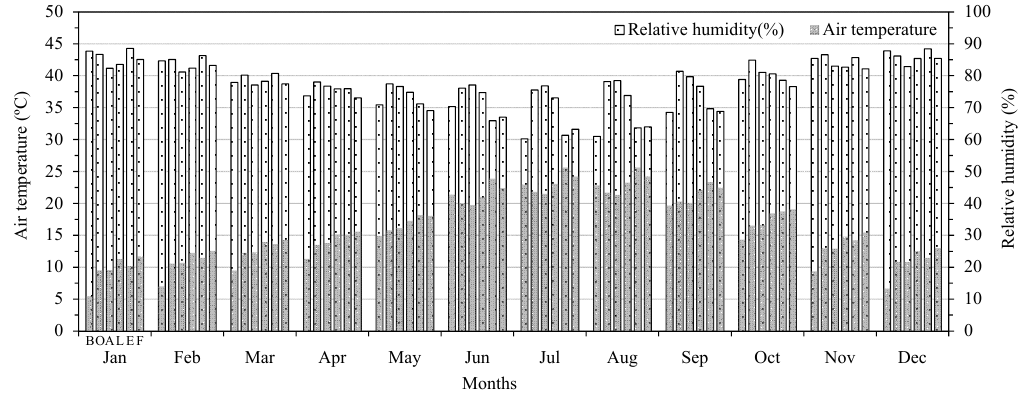
Figure 5. Portugal mainland: Six regions under study (Source: Adapted from Reference [31]).